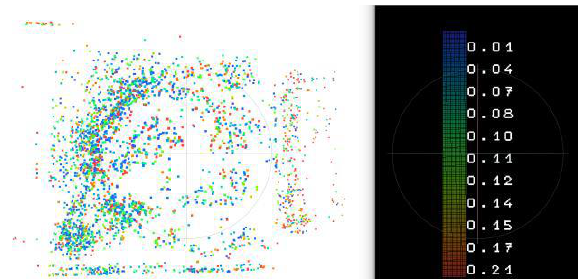
Figure 8 . Tie point residuals after the camera calibration (Calantropio et al.